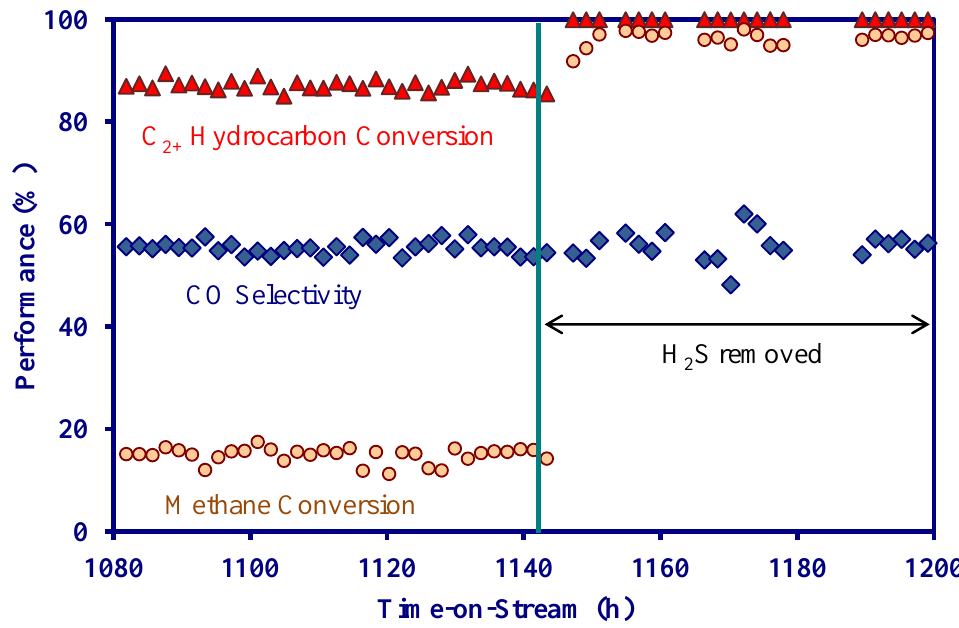
Figure 9. Reforming of biomass gasification products on MNS-washcoated cordierite monolith in the presence of NH GHSV = 10,000 h −1 , 14.4% H 1.6% H S (when 2